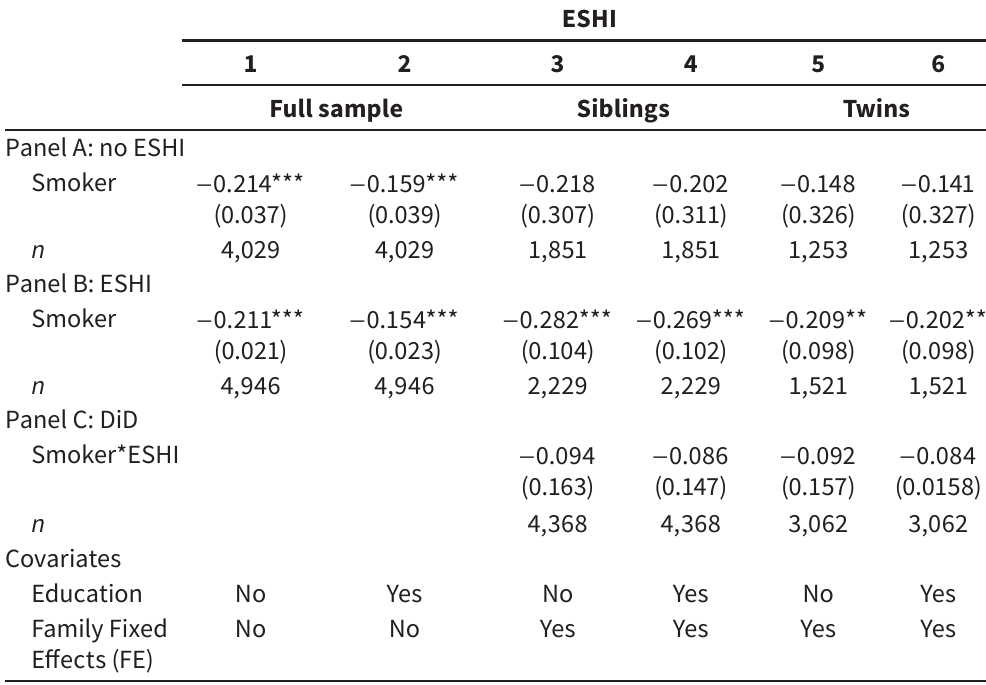
The earnings impact of smoking by